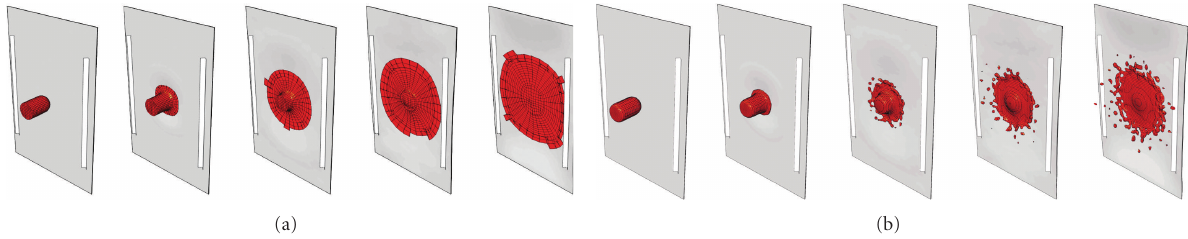
Figure 10: Bird strike simulation on composite plate with the (a) Lagrangian and (b) Eulerian impactor